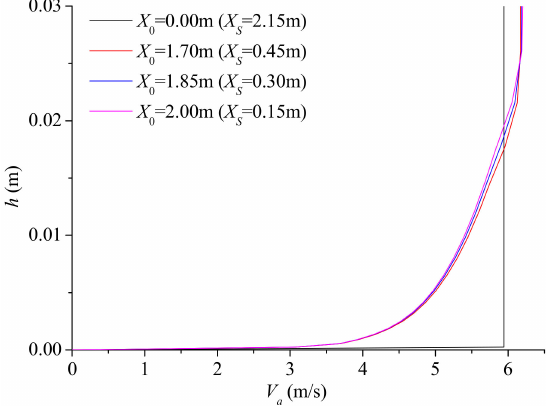
Figure 6. Simulated axial velocity profiles in shroud-surface boundary layer, where h is the normal distance from the shroud surface, X 0 is the distance measured from the inlet, and X S is the distance to the nose of shaft